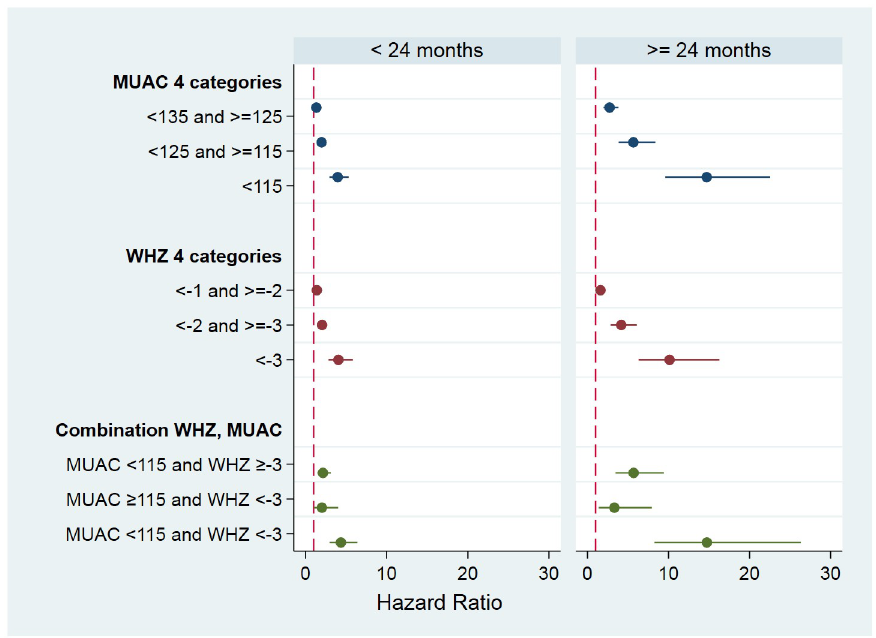
Fig 4. Hazard ratios with 95% CI resulting from Cox proportional hazard regression models according to age group. The reference categories are � 135 mm for MUAC; � -1 Z-scores for WHZ; and MUAC � 115 and WHZ � -3 for the combination of